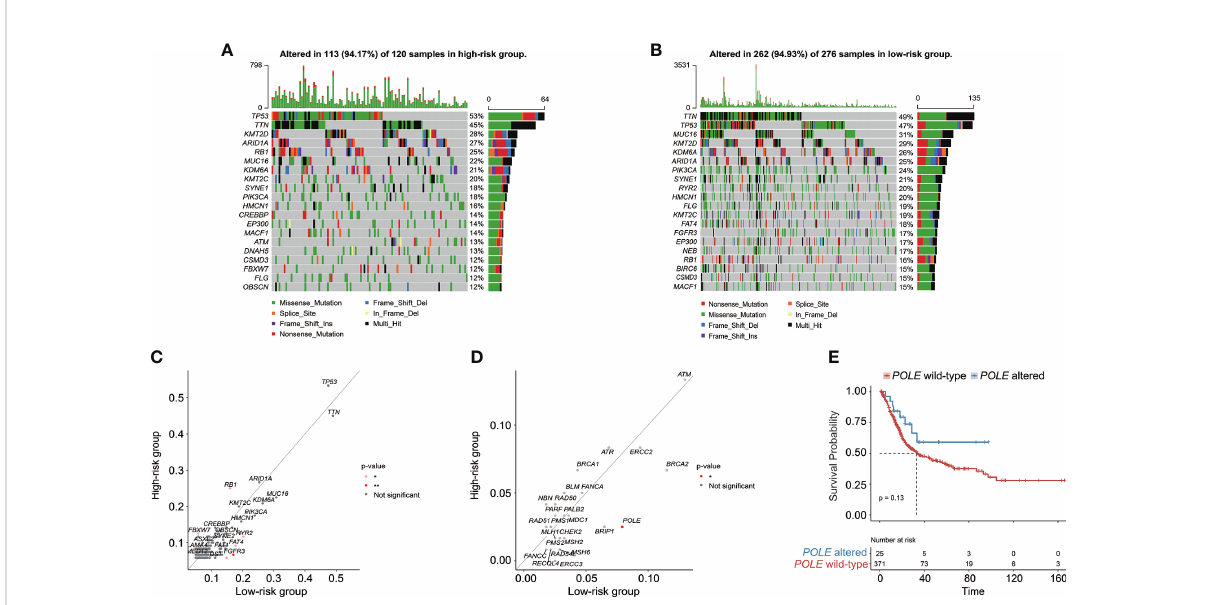
FIGURE 7 The characteristics of genomic alterations between high-risk and low-risk patients from the TCGA-BC cohort. The oncoprint plots exhibited the genomic alteration pro fi le of the high-risk group (A) and low-risk group (B) . (C) The genomic alteration enrichment analysis demonstrated the prevalently altered genes between high-risk and low-risk groups. (D) The alteration enrichment analysis of DNA damage response (DDR) genes between high-risk and low-risk groups. (E) Kaplan – Meier curve analysis for BC patients with or without POLE